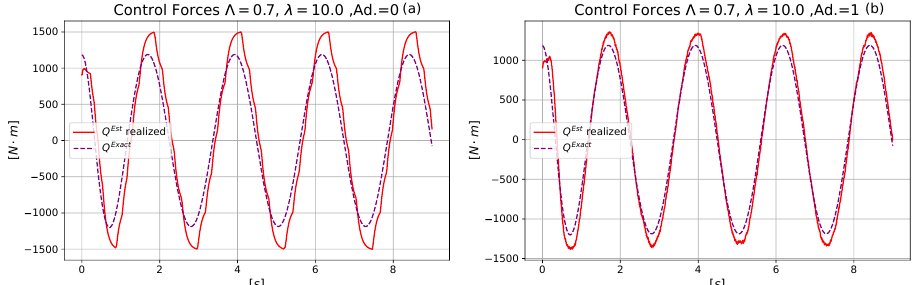
Figure 12. The control torque Q 1 for the small amplitude and high circular frequency of the nominal trajectory for which the adaptive controller was able to use only the originally learned data. ( a ): Non- adaptive, ( b ): adaptive control.